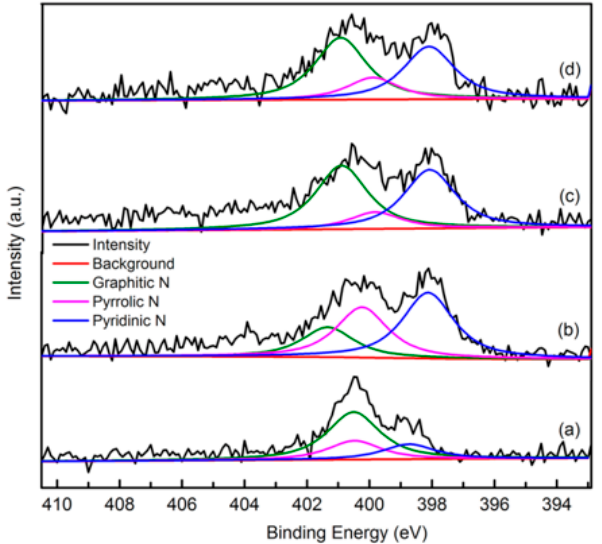
Figure 8. Narrow scanning N 1s XPS spectra of (a) green petroleum coke, (b) N-GLPs 750 2 , (c) N-GLPs 750 4 , and (d) N-GLPs 750 6 .